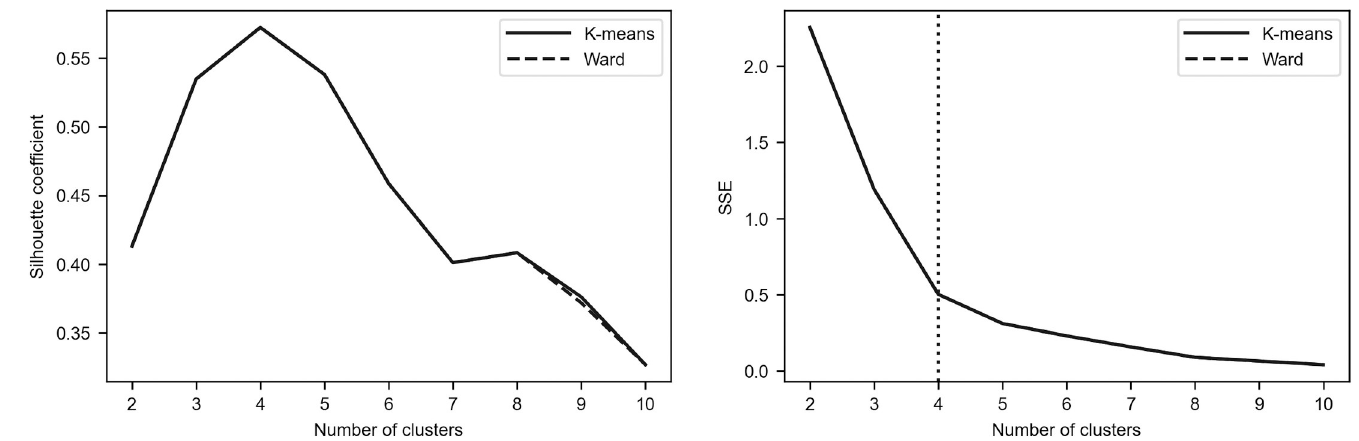
Fig 5. Silhouette coefficients and elbow